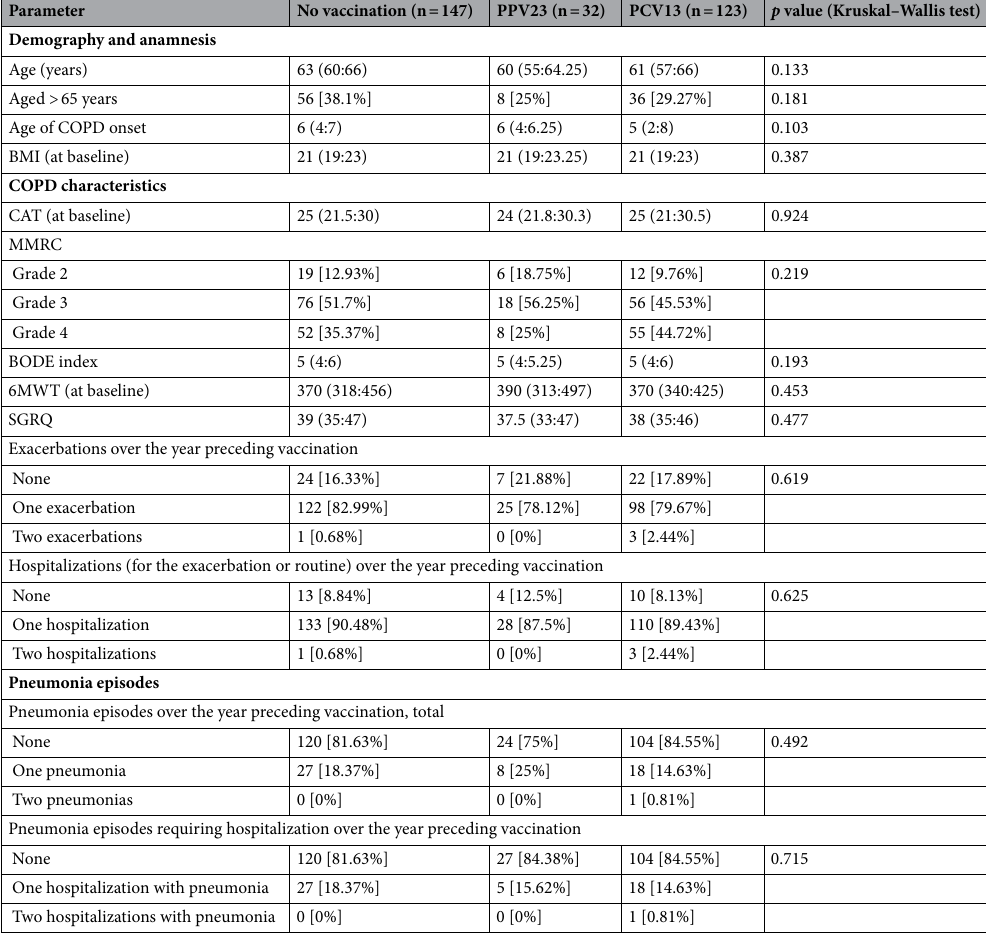
Table 1. Baseline demographic and clinical characteristics of patients enrolled in the study. Continuous numeric values are shown as Median (interquantile range); categorical values are shown as absolute numbers and percentage of group size. COPD chronic obstructive pulmonary disease, BMI body mass index, CAT COPD assessment test, MMRC Modified Medical Research Council dyspnea scale, 6MWT 6-min walk test, SGRQ St. George’s Respiratory